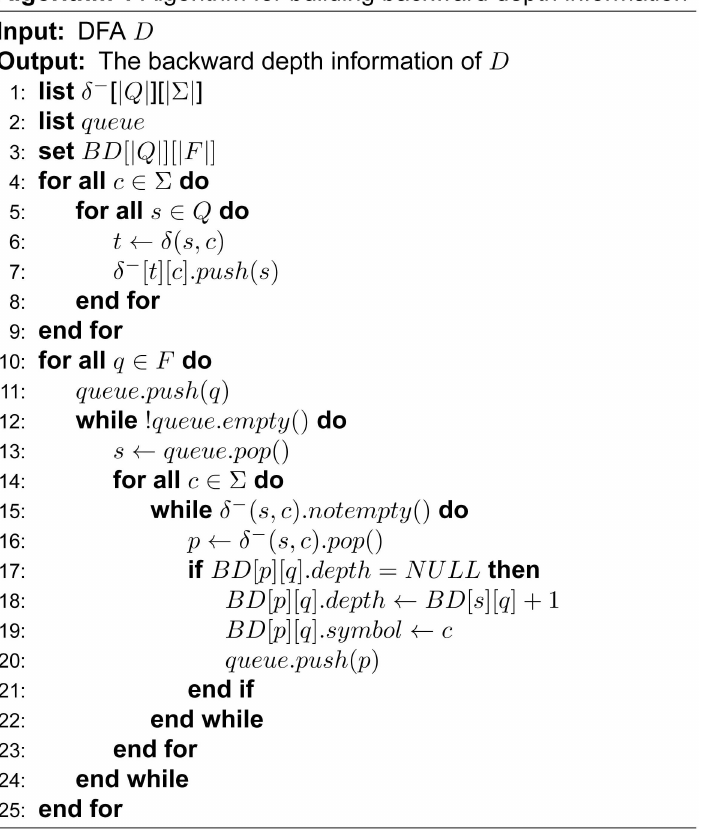
Fig 3. Algorithm for building backward depth